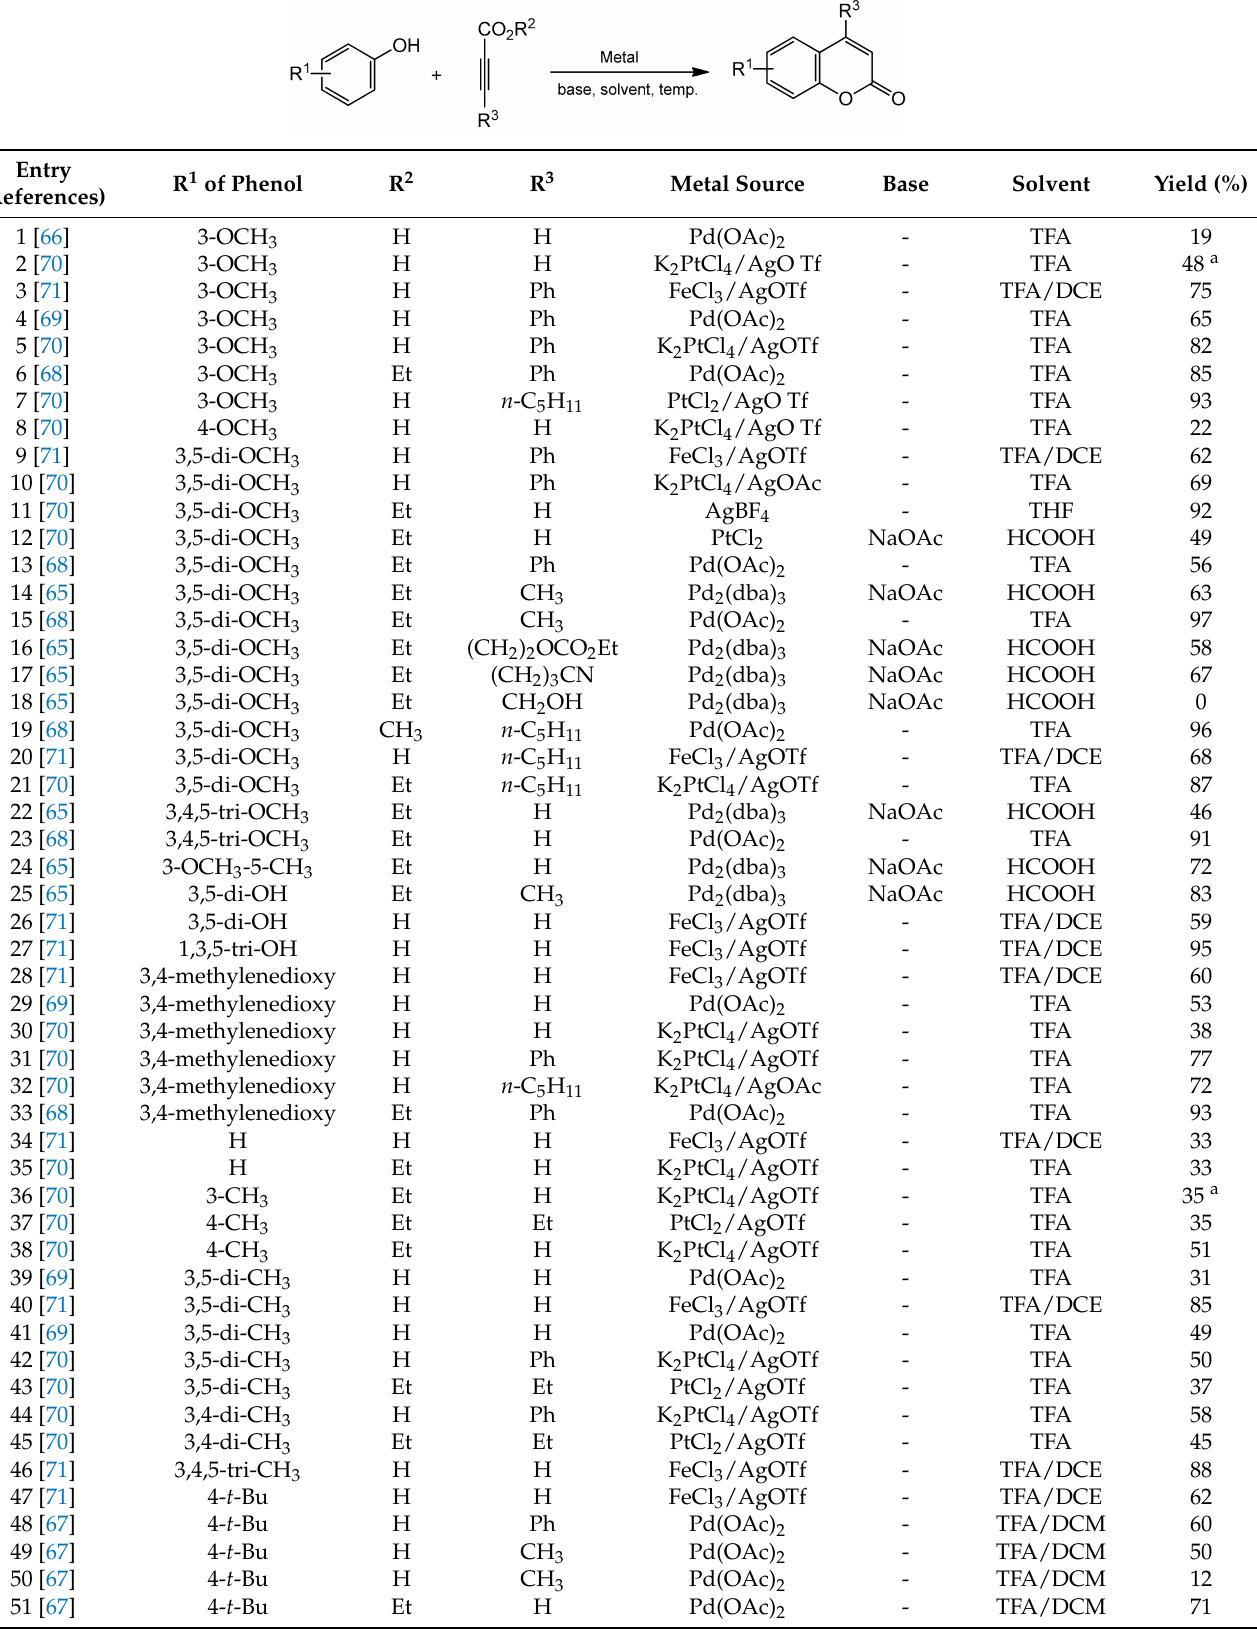
Table 1. Synthesis of coumarins via metal-catalyzed